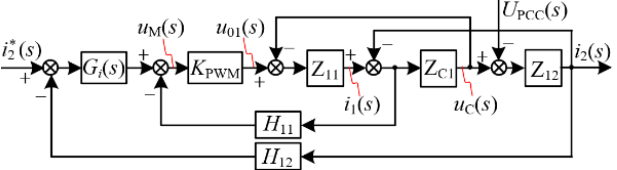
Figure 3. Configuration of single-current loop digital control strategy.